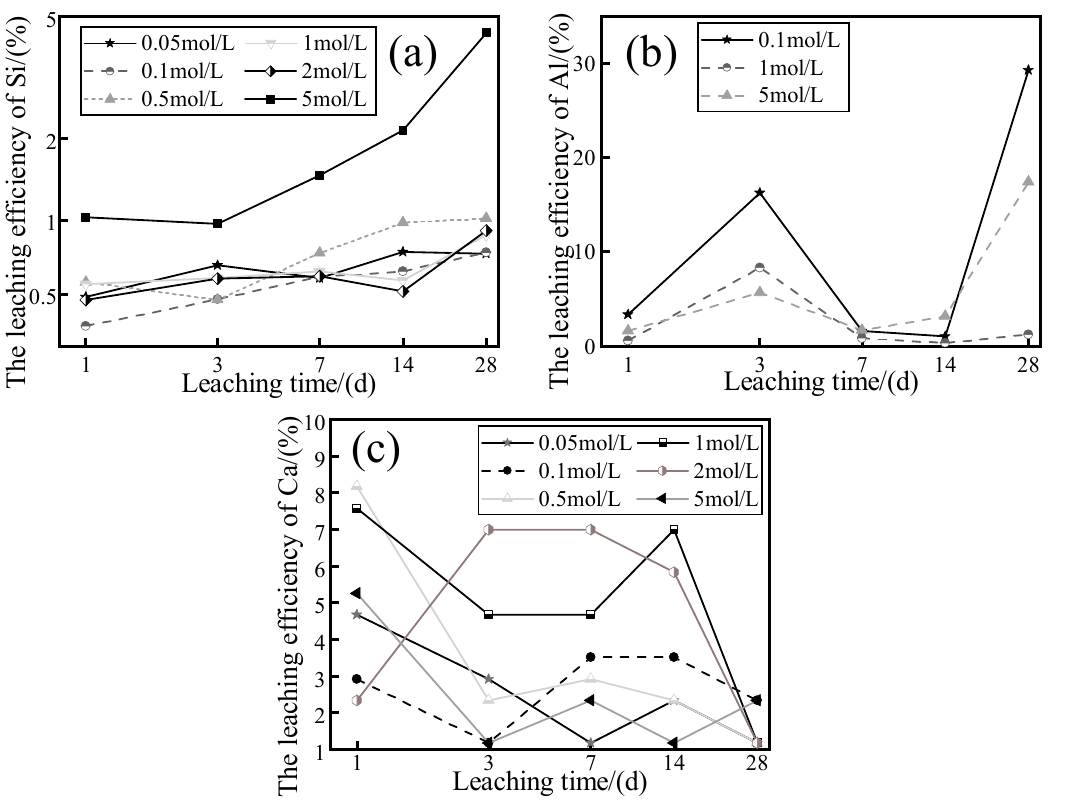
Figure 5. The e ff ect of the concentration of NaOH solutions on the ion leaching e ffi ciency. ( a ) The Figure 5. The effect of the concentration of NaOH solutions on the ion leaching efficiency. ( a ) The ion ion leaching e ffi ciency of Si, ( b ) the ion leaching e ffi ciency of Al, and ( c ) the ion leaching e ffi ciency leaching efficiency of Si, ( b ) the ion leaching efficiency of Al, and ( c ) the ion leaching efficiency of of Ca.